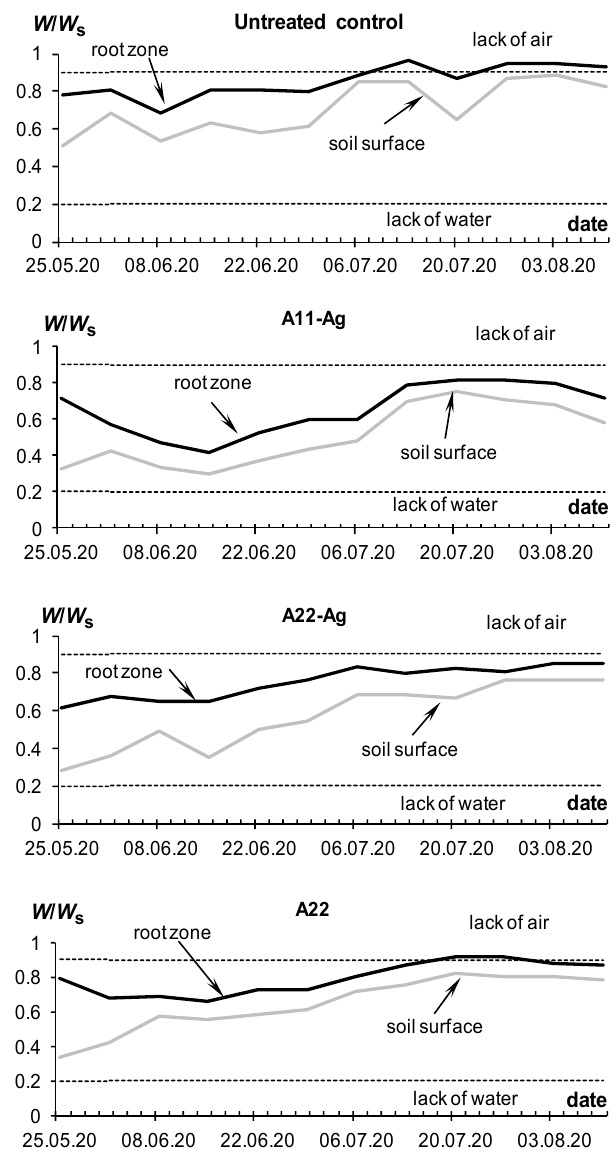
Figure 14. Soil water–air regime under the influence of irrigation and gel-forming conditioners (Moscow region, Retisol, drip irrigation, 2020). The dotted lines are the critical limits of the optimal values for the W / W s index (see Figure 9).